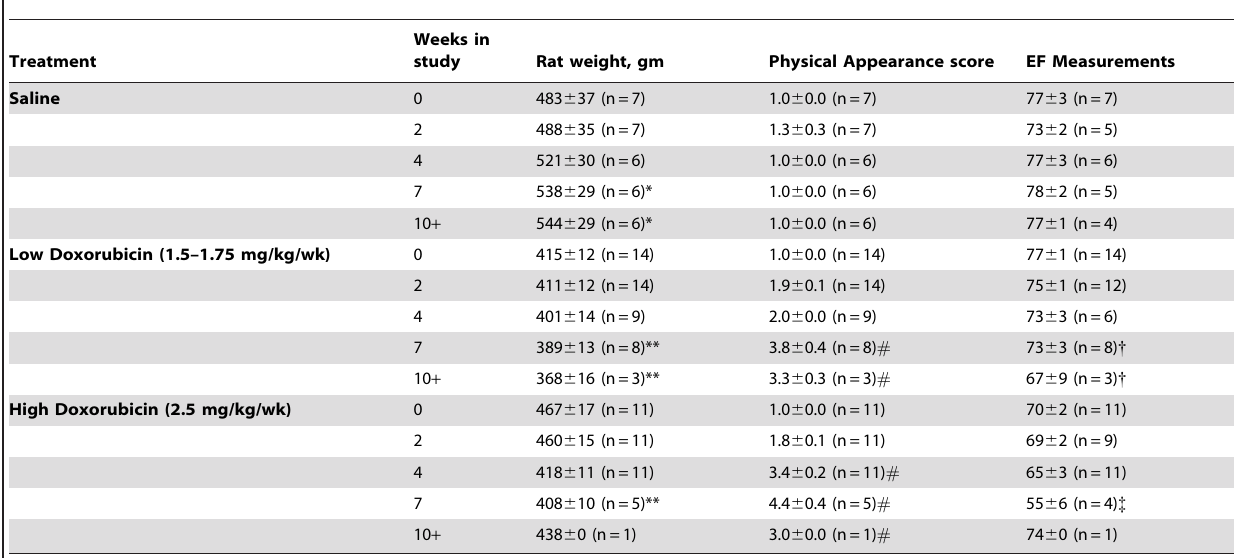
Table 1. Effect of DOX on rat physical parameters and EF measurements (mean 6 standard error of the mean.